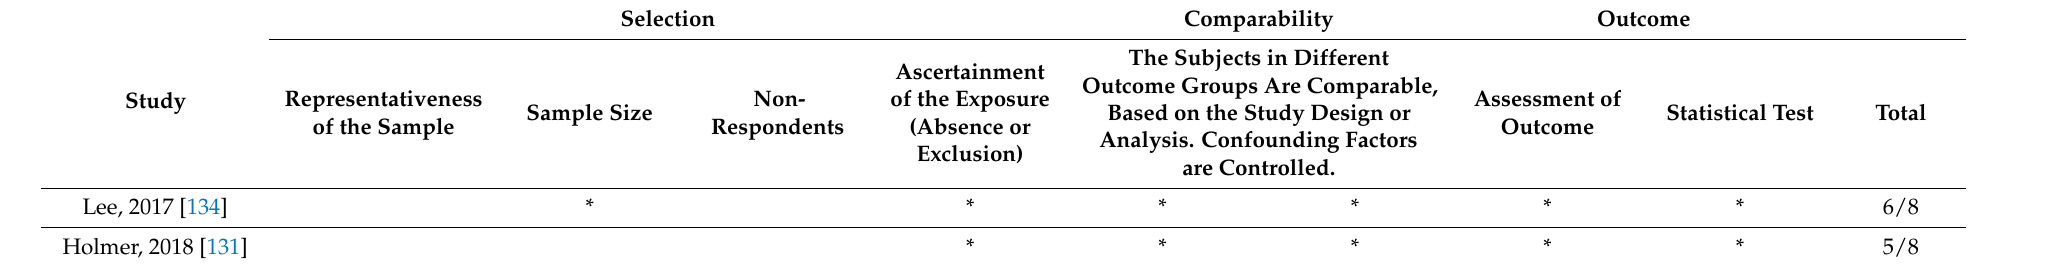
Table 5. Quality of cross-sectional studies assessed using the Newcastle–Ottawa scale.